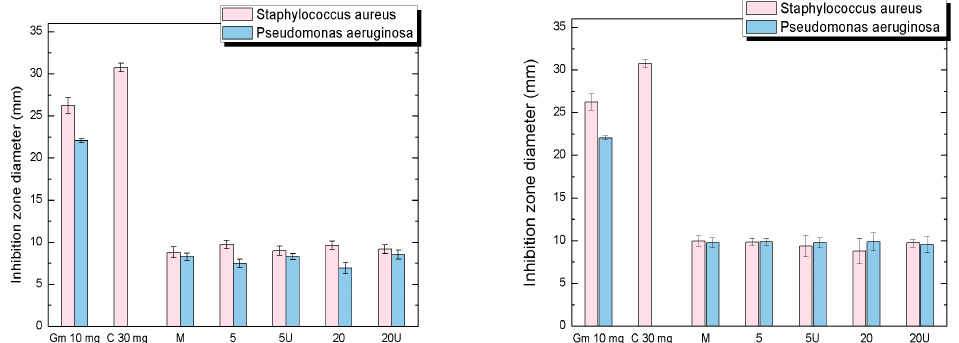
Figure 5. Antimicrobial effect of Ag/C ( left ) and Ag/PVP ( right ) textile samples (control–M and irradiated at 5 and 20 kGy in a dry and wet state (u)) compared to gentamicin 10 mg (Gm 10 mg) and chloramphenicol 30 mg (C 30 mg).